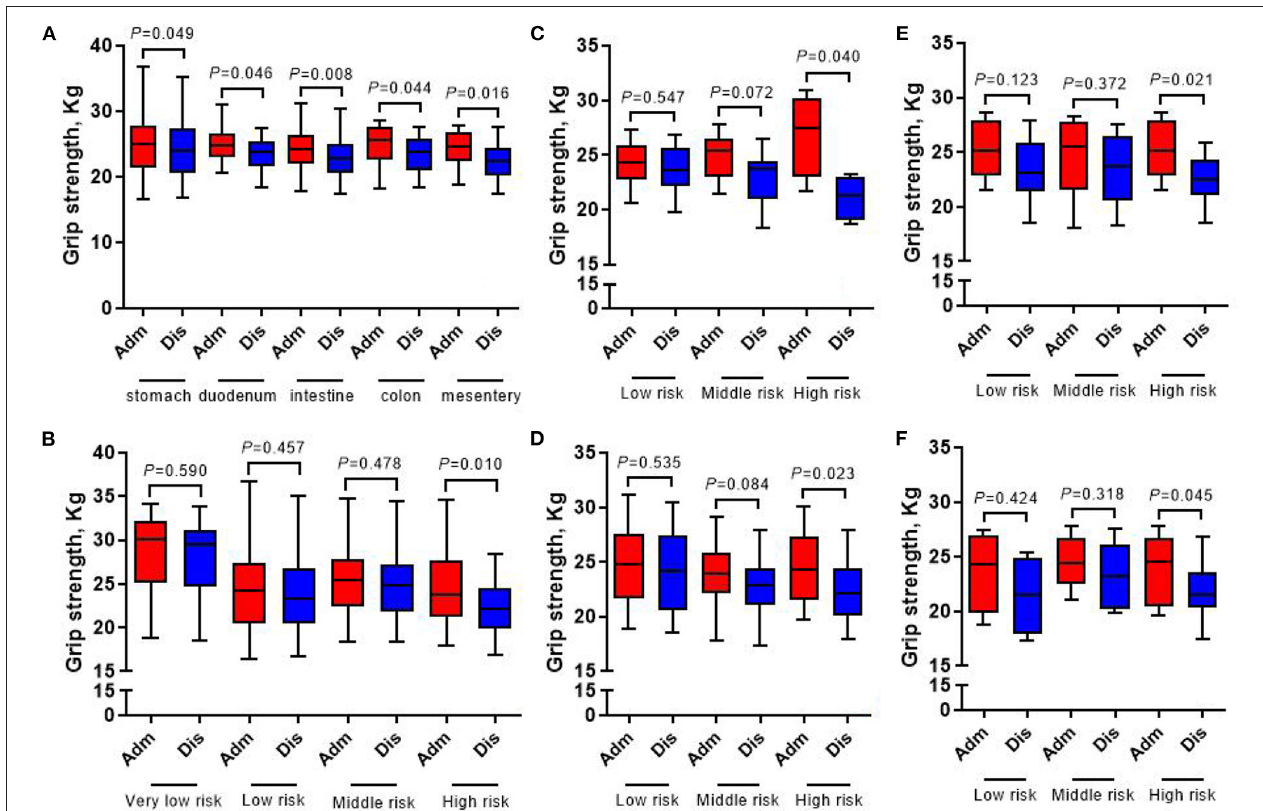
FIGURE 6 | Changes of grip strength in 413 GIST patients at admission and discharge. (A) Total; (B) stomach; (C) duodenum; (D) intestine; (E) colorectal; (F)